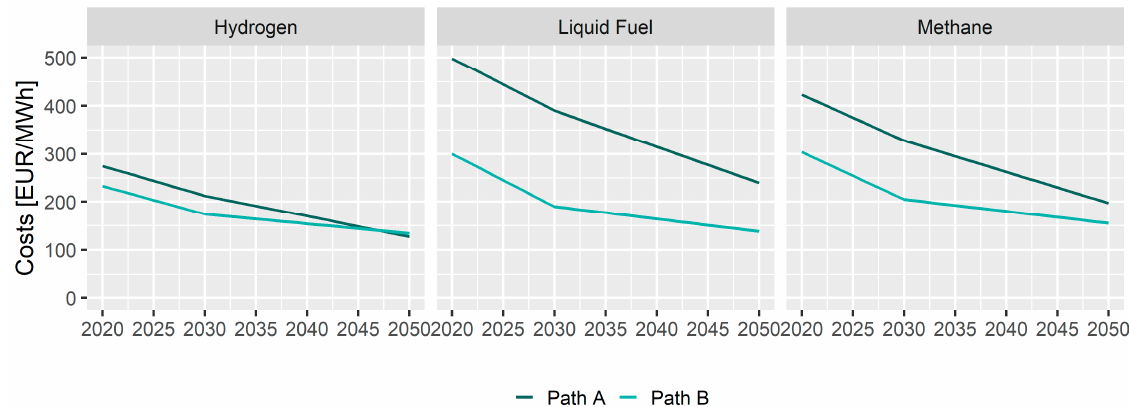
Figure 1. Different cost assumptions for the import of synthetic fuels, in EUR/MWh. The calculation of these costs was based on [37].